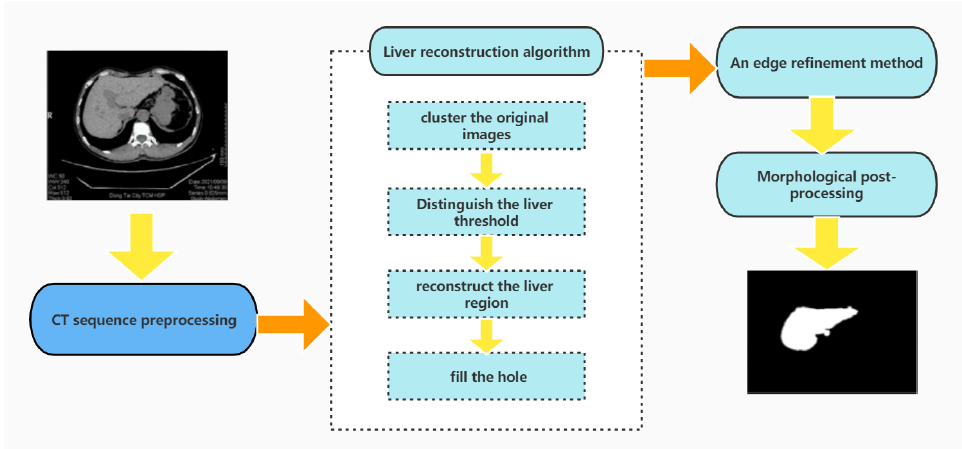
Figure 1. Flowchart of the proposed